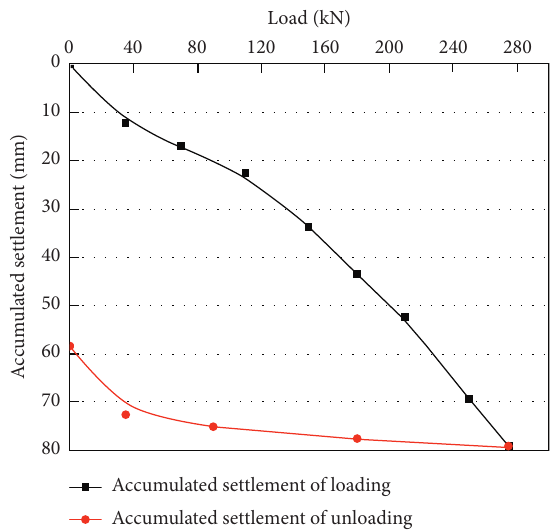
Figure 12: Accumulated settlement under vertical load for Test